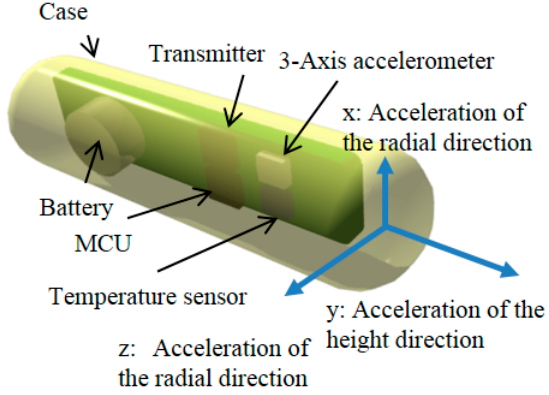
Figure 2. Model of a bolus-type sensor node